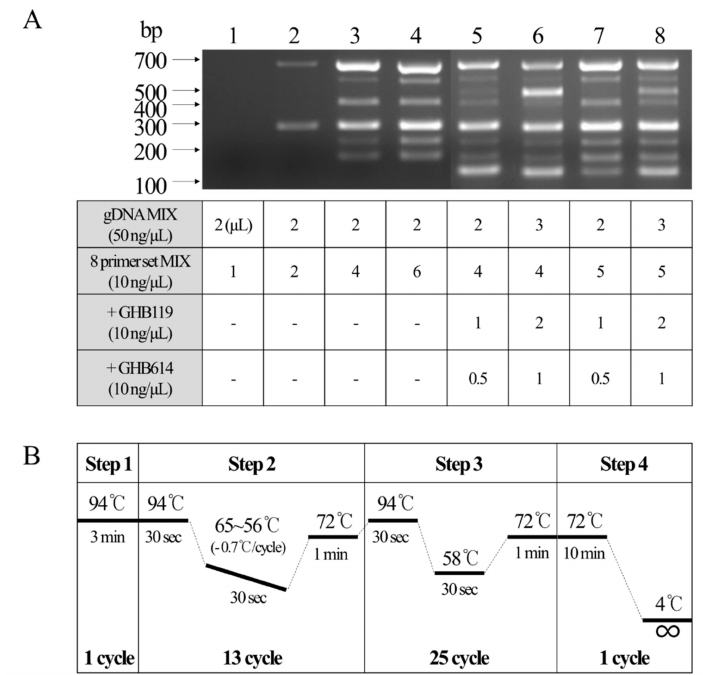
Figure 4. Multiplex PCR experiments were performed under various conditions. ( A ) Electrophoresis gel image using multiplex eight primer PCR method on LM cotton with varying conditions, including concentration of genomic DNA and eight primer sets. ( B ) Schematic diagram of the optimal multiplex PCR conditions.